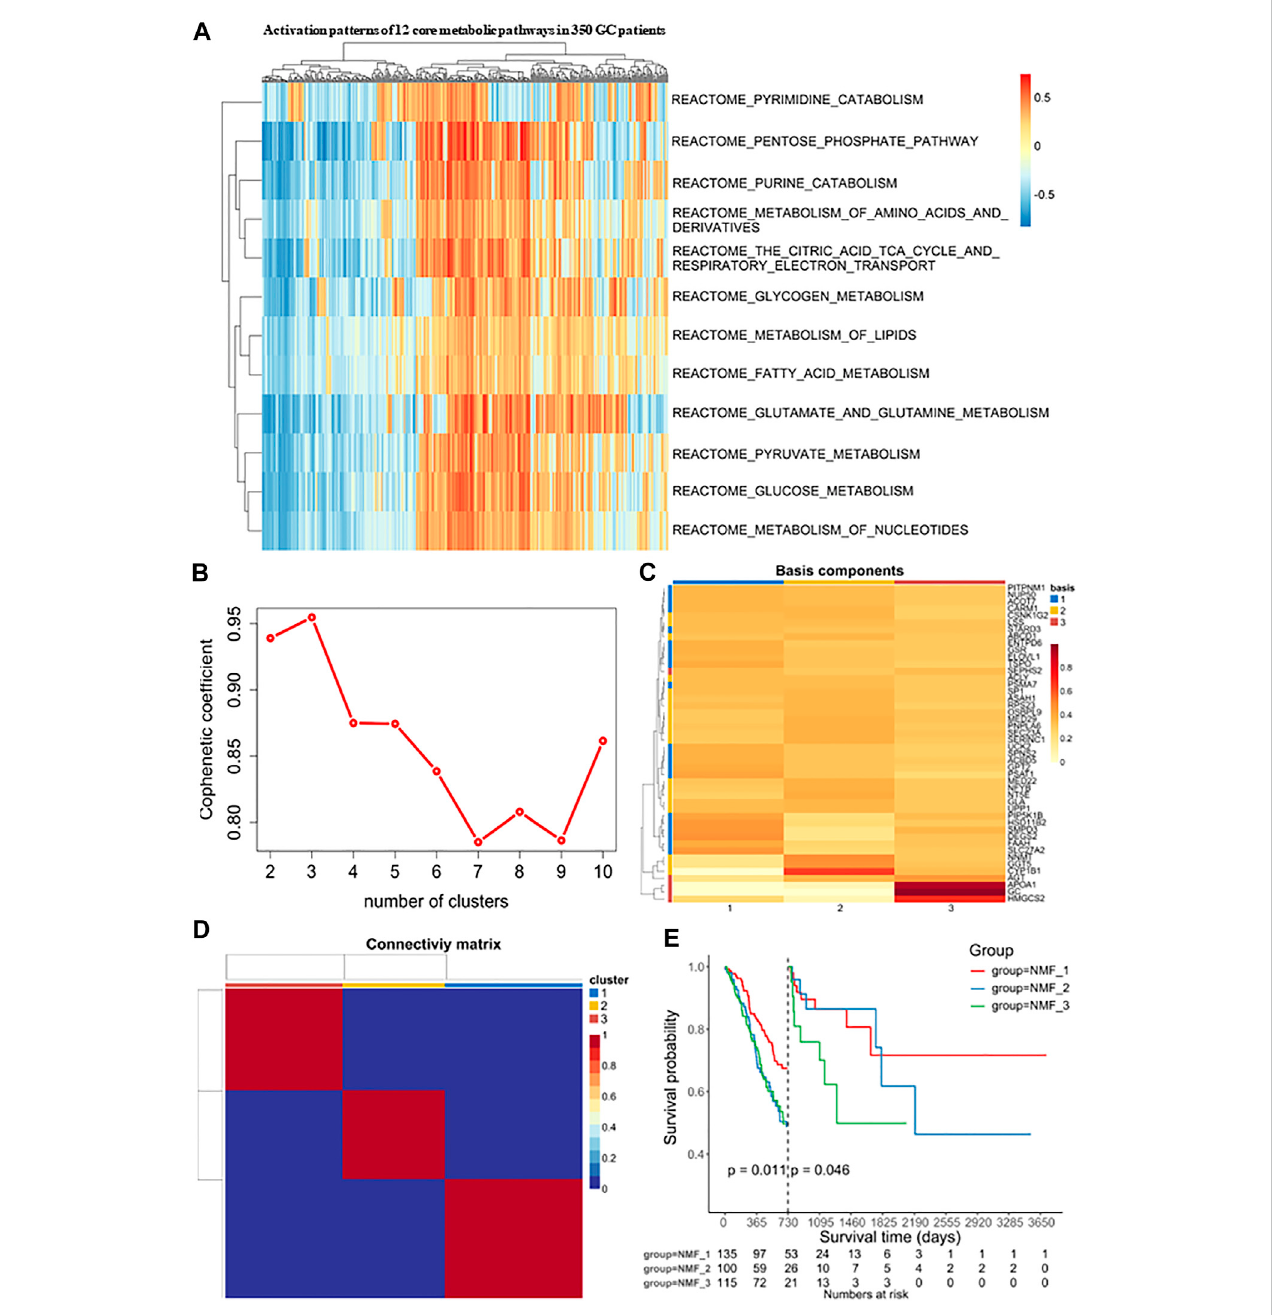
FIGURE 2 Identi fi cation of molecular isoforms for metabolic signatures of gastric cancer based on NMF (A) Heatmap of enrichment score of 12 main metabolic pathways gene sets in GC and adjacent non-tumor samples, which demonstrated metabolic heterogeneity among patients with gastric cancer. (B) The optimal number of clusters was selected with factoextra package. (C) Classi fi cation of expression pro fi les into 3 categories based on signature levels using NMF. (D) GC samples were clustered by non-negative matrix factorization (NMF) method. (E) Survival analysis was used to evaluate the different survival patterns between metabolic